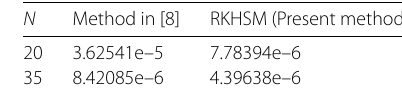
Table 2 Maximum absolute error for Example 2 ( n = 5) N Method in